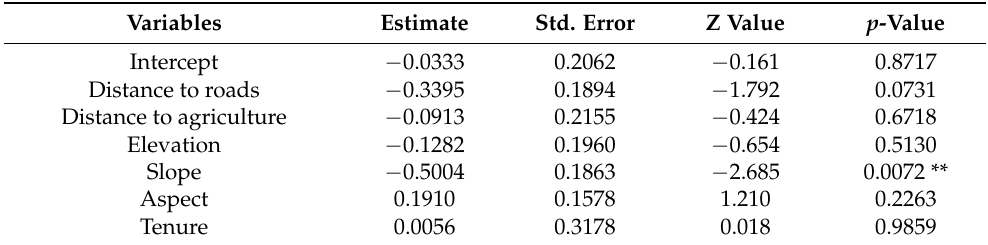
Table 4. Result of the logistic regression predicting tropical forest loss to agriculture with all explica- tive variables. ‘**’ significant at 0.01 level, ‘.’ significant at 0.1